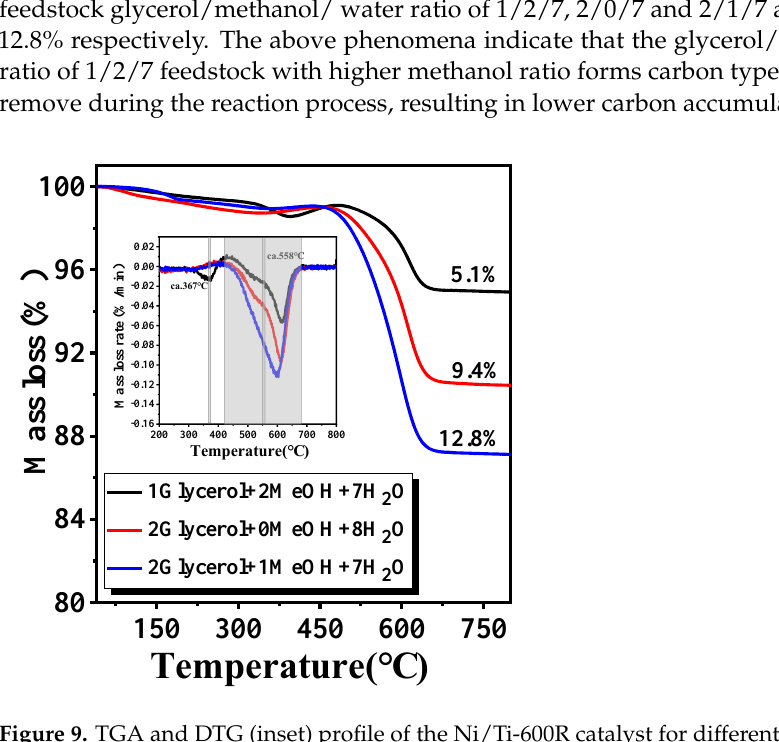
Figure 9. TGA and DTG (inset) profile of the Ni/Ti-600R catalyst for different mixed-alcohol feed after 20 h stability test. Table 3. Quantitative calculation of coke deposition on spent catalyst in 20 h.